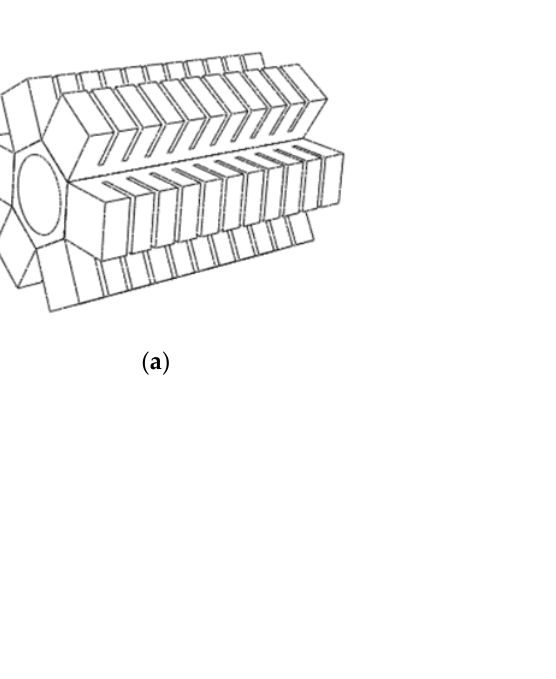
Figure 3. Deformation diagram of hexagonal prism soft-bodied bionic actuator. ( a ) Status of actu- ator not inflation. ( b ) State of bending deformation. ( c ) State of expansion deformation.